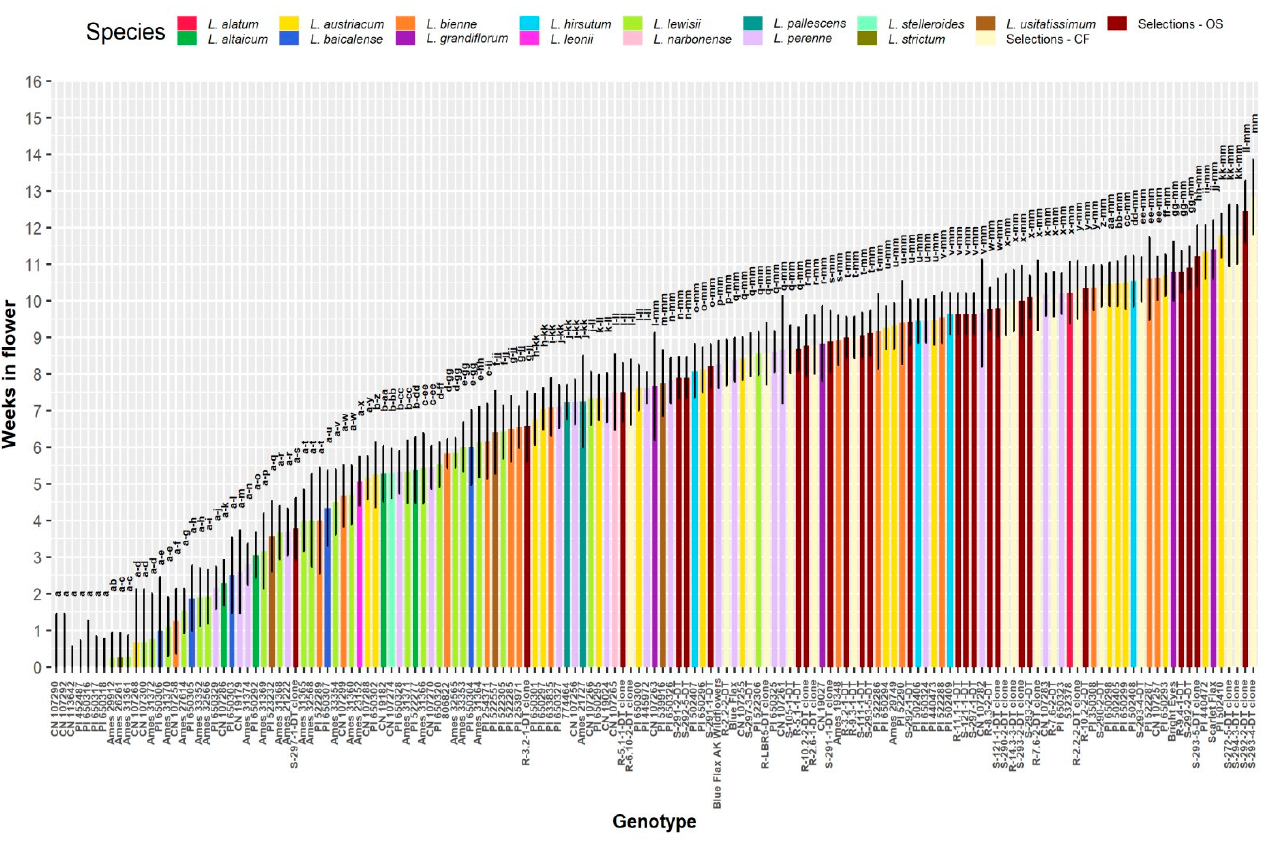
Figure 3. Mean ± S.E. number of weeks in flower for all wild species, CF and OS flax ( Linum ) genotypes with n ≥ 3 observations. Means separations (5% HSD) are displayed as letters above the columns denoting significance.